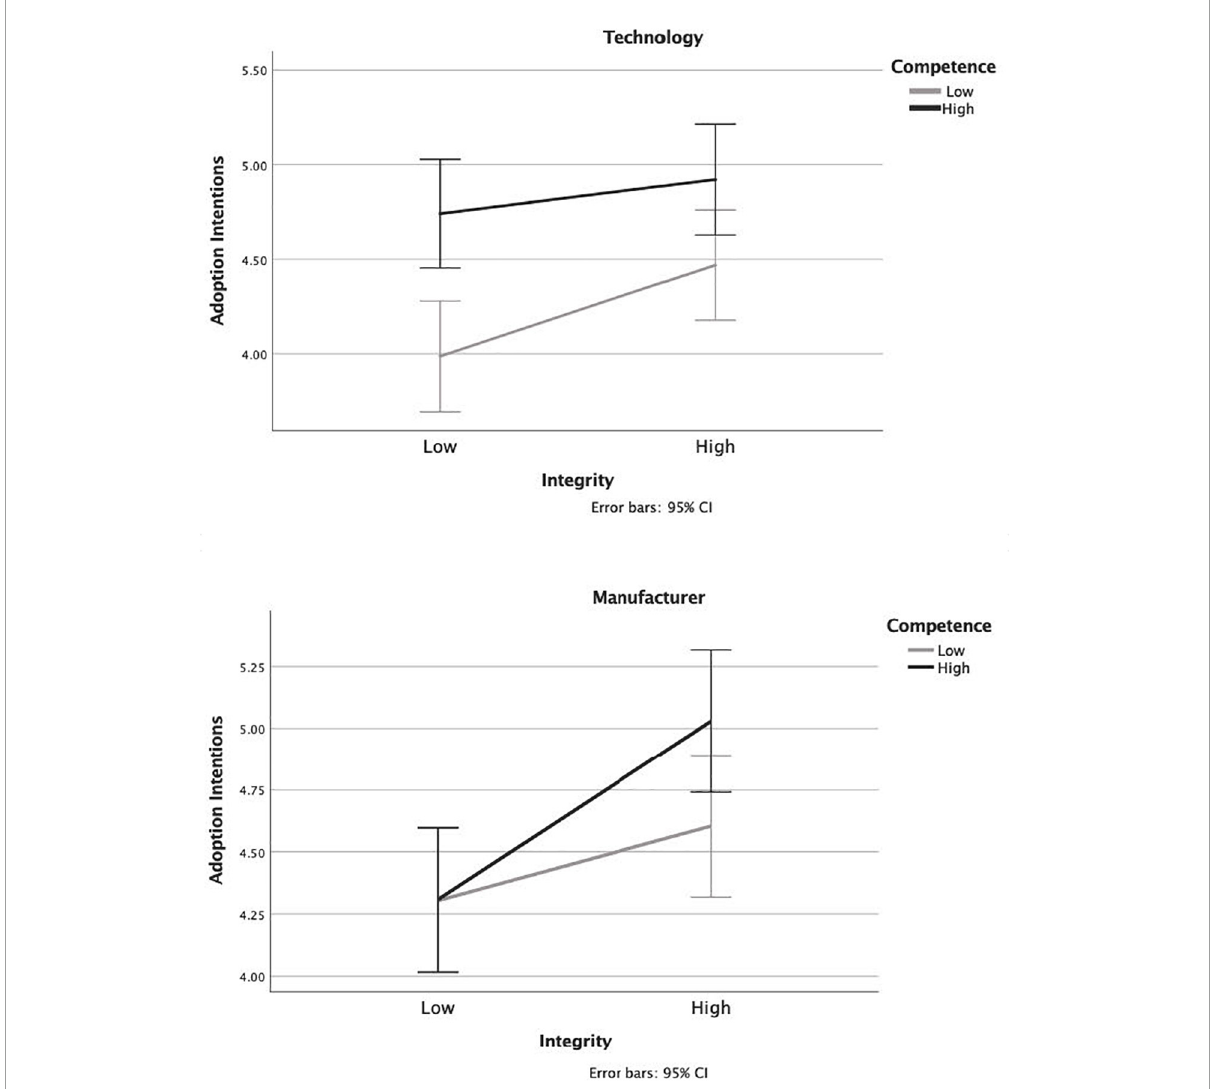
FIGURE2 Study 3 adoption intent ratings for messages about the autonomous vehicle (AV) technology (top) and manufacturers (bottom) . Error bars show 95% confidence